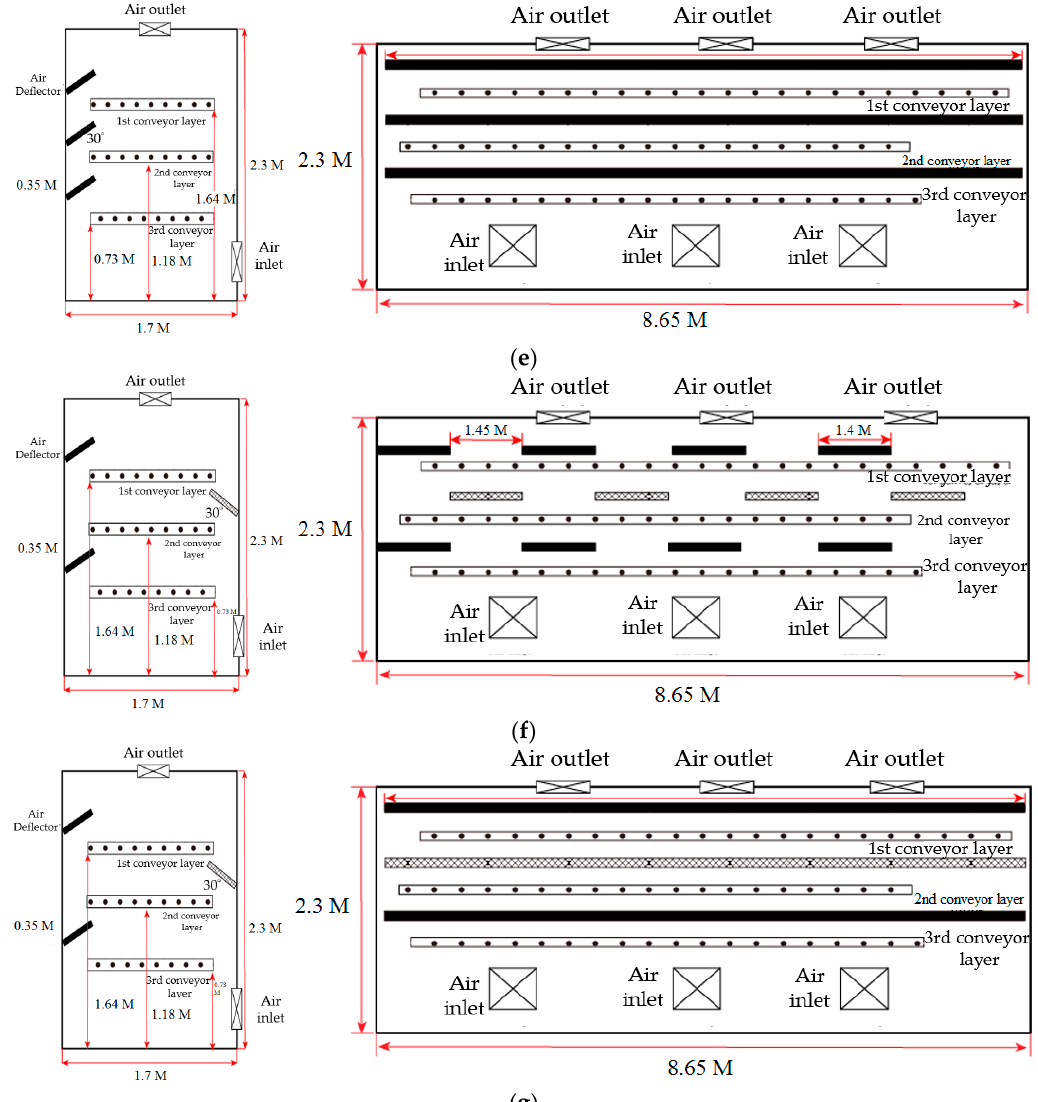
Figure 3. Seven deflector design types inside the drying chamber. ( a ) Side view and front view of the drying chamber with type I deflector design. ( b ) Side view and front view of the drying chamber with type II deflector design. ( c ) Side view and front view of the drying chamber with type III deflector design. ( d ) Side view and front view of the drying chamber with type IV deflector design. ( e ) Side view and front view of the drying chamber with type V deflector design. ( f ) Side view and front view of the drying chamber with type VI deflector design. ( g ) Side view and front view of the drying chamber with type VII deflector design.